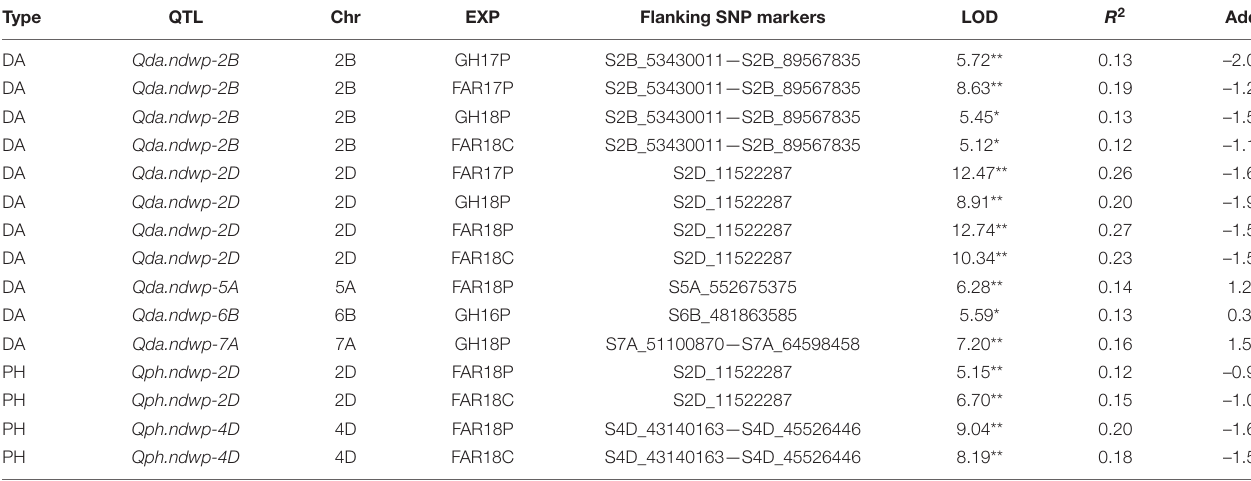
TABLE 5 | Summary of QTL detected for agronomic traits by composite interval mapping (CIM) in the Wheaton/Surpresa RIL population.